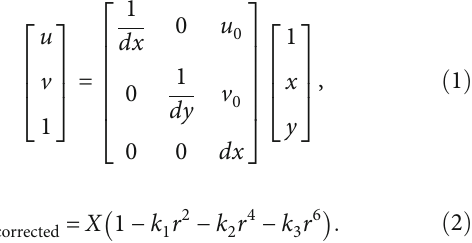
The correlation extended image, redistributing the num- ber of pixels in the gray level so that the frequency of gray appearances in the blurred image is equally distributed among the gray levels, is the core of histogram equalization processing [19]. A suitable mapping function is sought, where the gray levels after histogram equalization are represented by and the original image gray levels are represented by, to achieve image enhancement, which applies knowledge related to gray- scale transformation in image processing. The method uses a single-valued monotonic nondecreasing function as the enhancement function, and the gray level value still needs to be within the original gray level range after the change, only then can the initial image gray level light and dark change trend with the same as before. After the histogram equaliza- tion process, the gray level probability density distribution of the image is more uniform, and the image pixels are more equalized, which increases the image contrast and the image characteristics are more signi fi cant and more conducive to the subsequent image for e ff ective recognition.